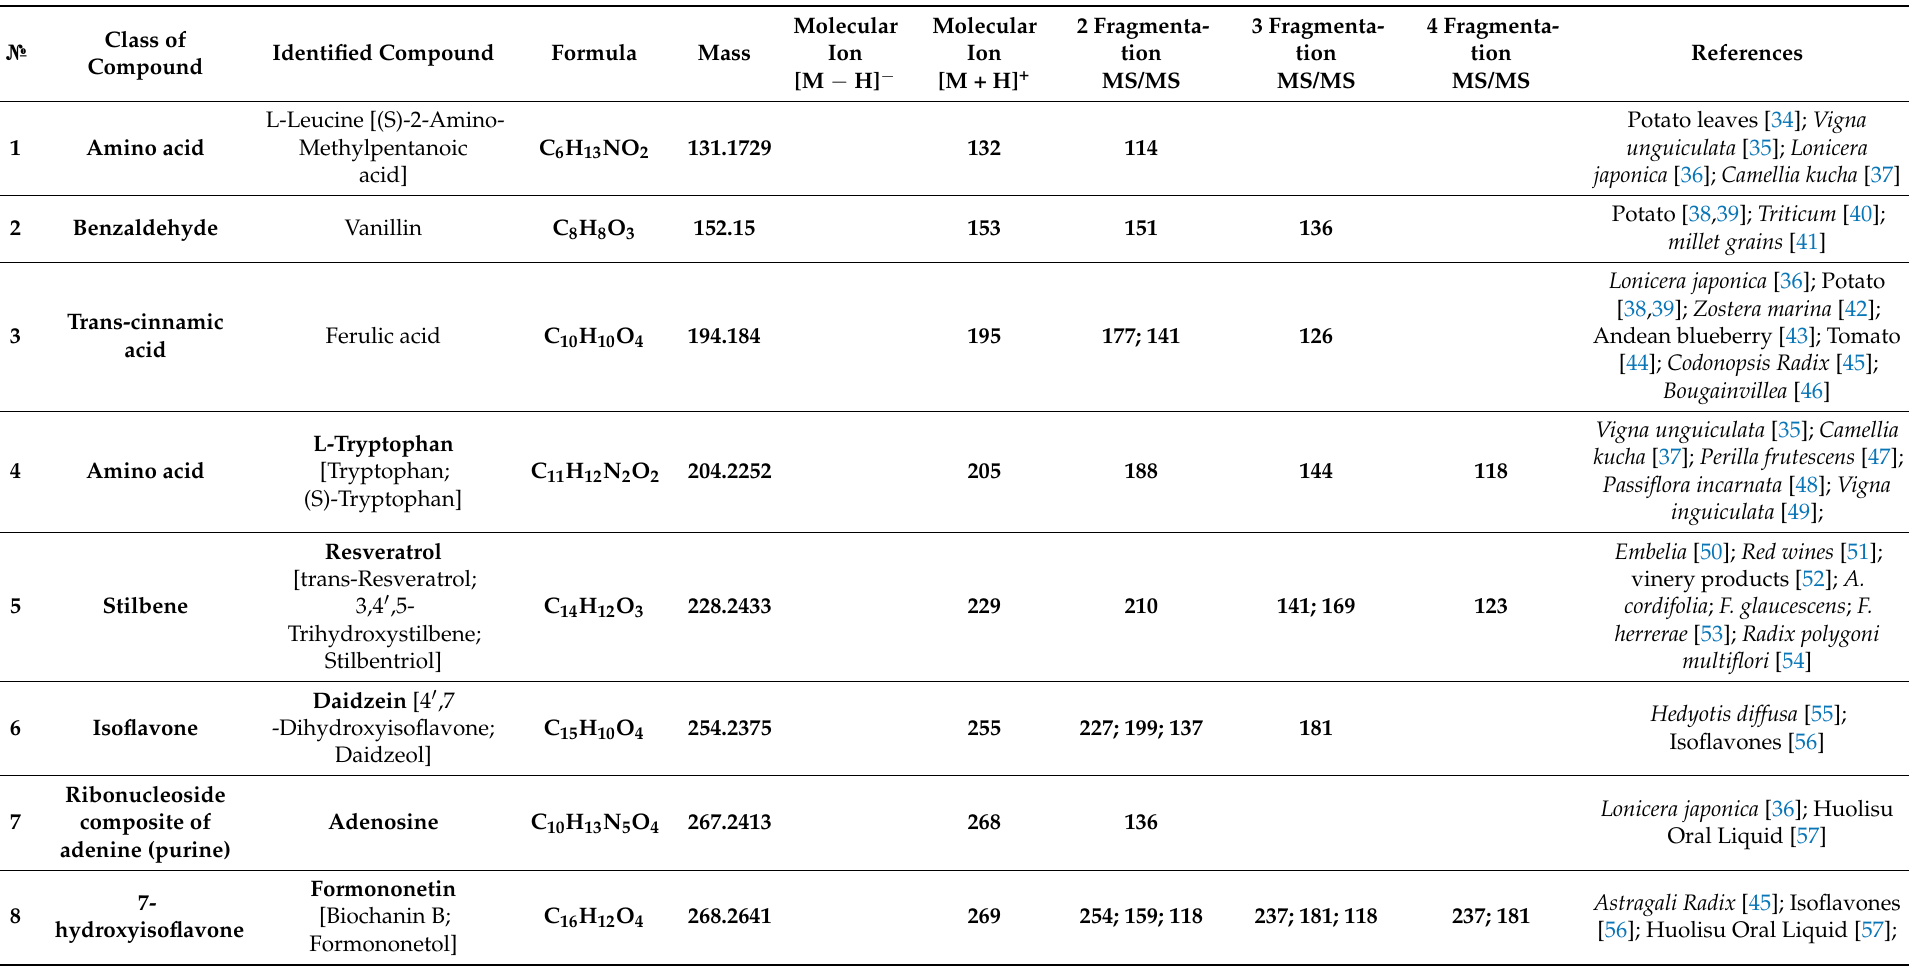
Table 1. Compounds identified from the extracts of seven soybean varieties in positive and negative ionization modes by HPLC ion trap MS/MS: k-11538